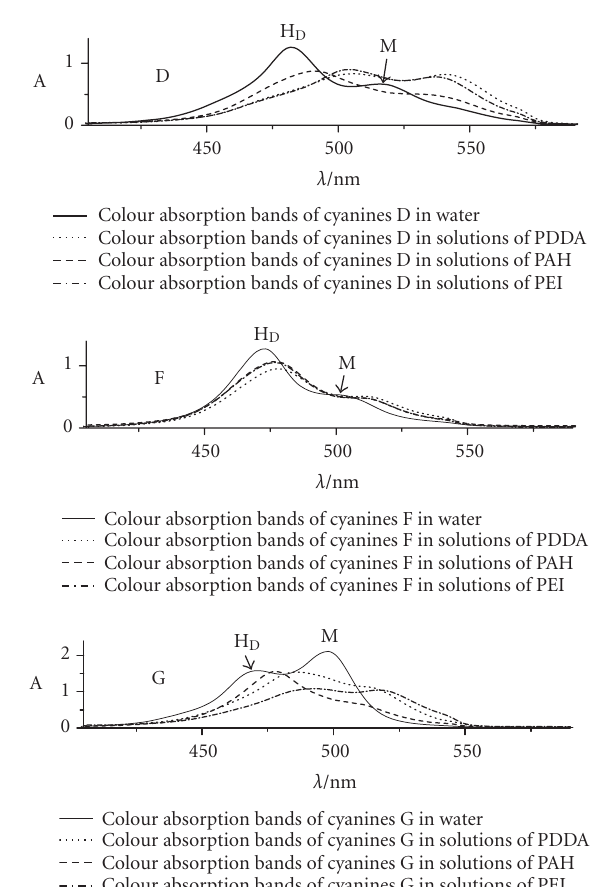
Figure 1: Colour absorption bands of cyanines D, F, and G in water (solid) and in solutions of PDDA (dotted), PAH (dashed), and PEI (dash-dotted). H D = H dimers, M = monomers. Con- centrations: dyes: 1 . 1 × 10 − 5 M (M = moles of monomer dm − 3